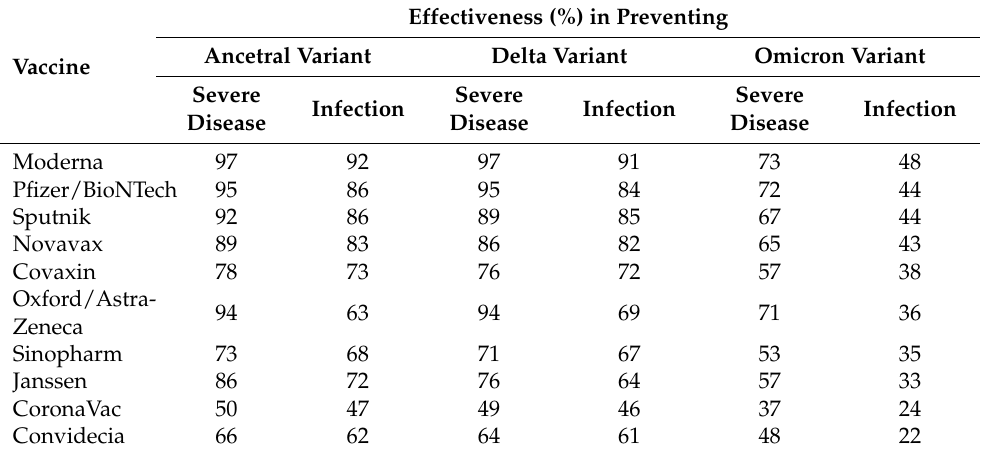
Table 1. Effectiveness of the available COVID-19 vaccines. Data from the Institute for Health Metrics and Evaluation (IHME)